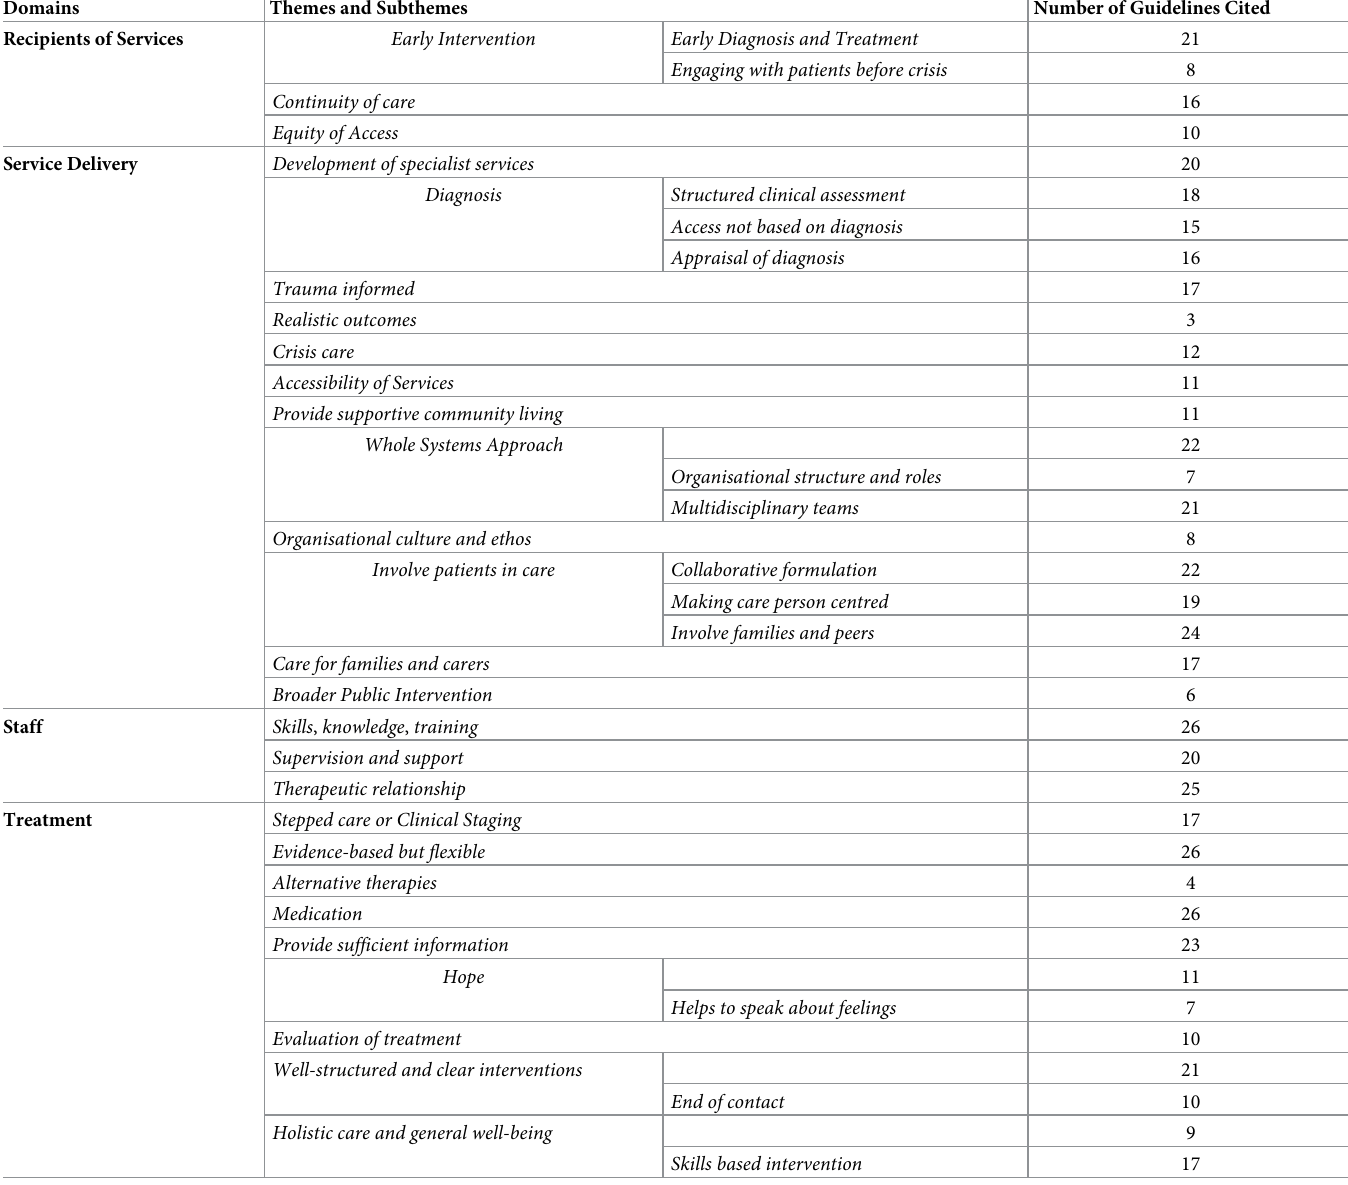
Table 3. Detailed description of themes and